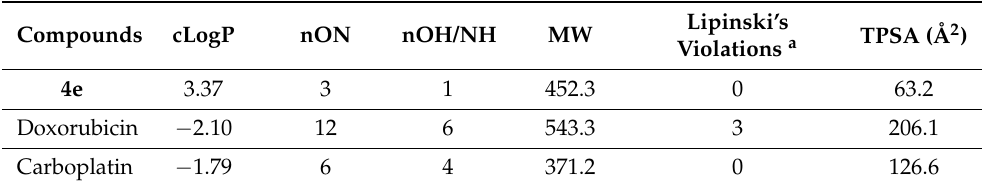
Table 4. Physicochemical descriptors of compound 4e and the control chemotherapy drugs doxoru- bicin and